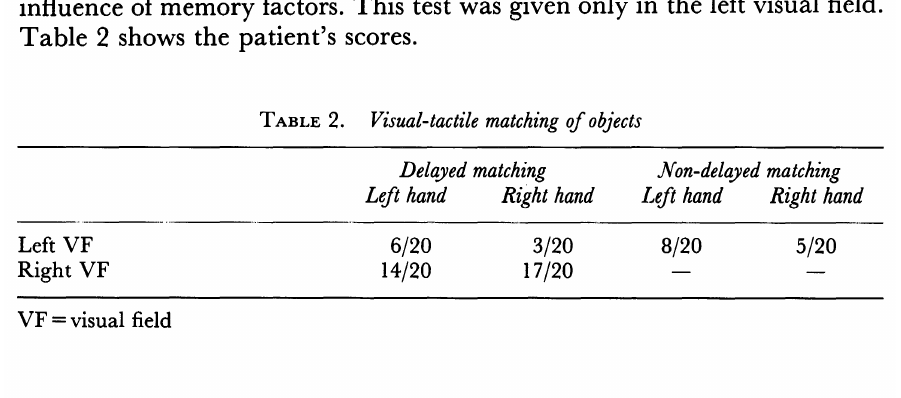
Visual-tactile matching rif